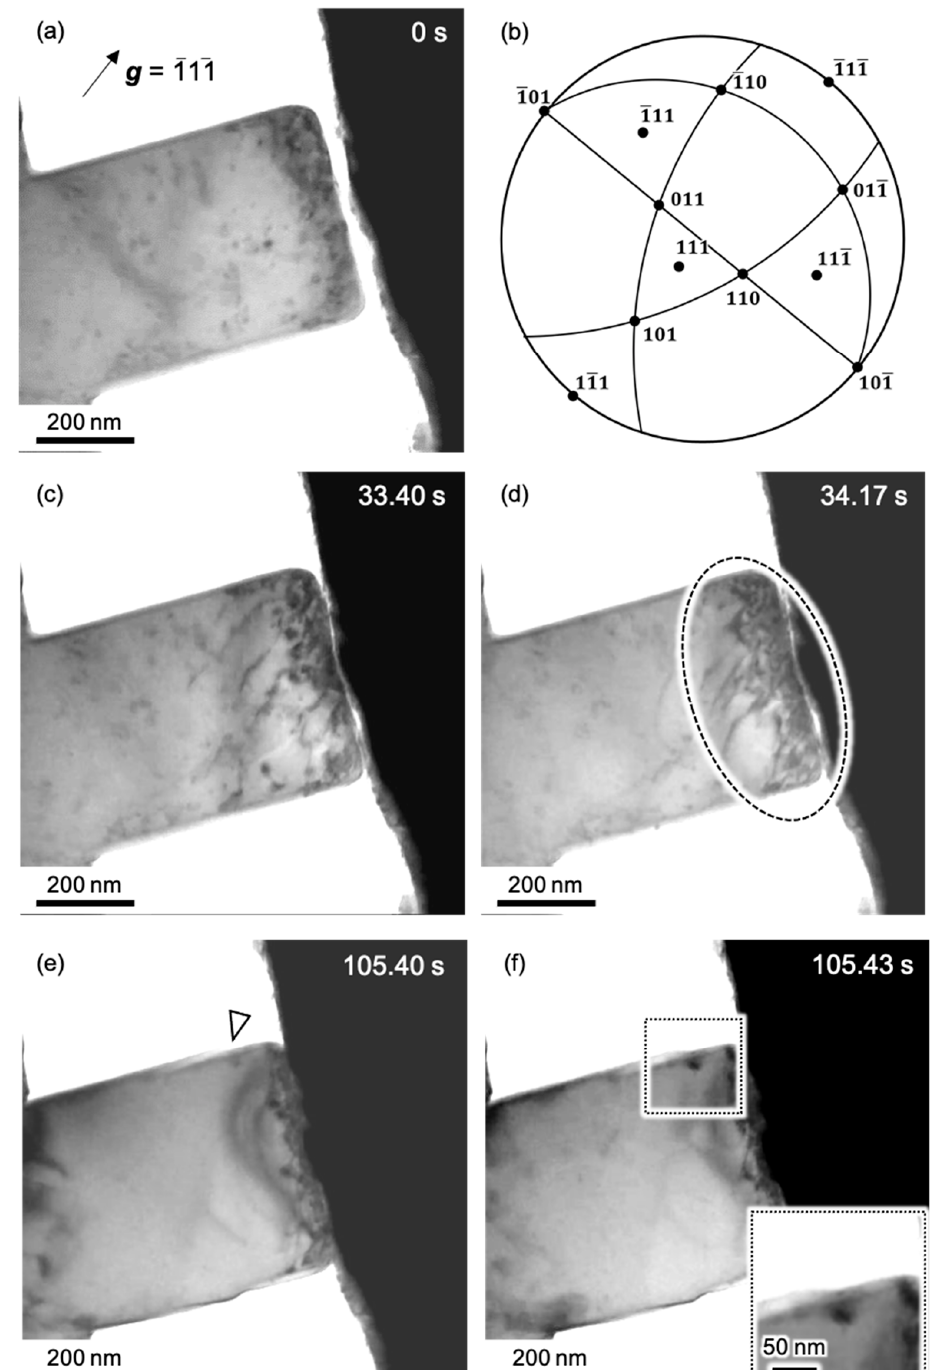
Figure 4. ( a ) Bright-field image of as-FIB Al pillar before compression. ( b ) Stereographic projection showing the geometry of the Al pillar in ( a ). ( c – f ) Series of snapshots during TEM in situ compression corresponding to points C-F on the S-S curve in Figure 3, respectively. The inset in the dotted square at the bottom right of ( f ) shows an enlarged image of the step structure. The region of the dotted square corresponds to the region indicated by a single arrowhead in ( e